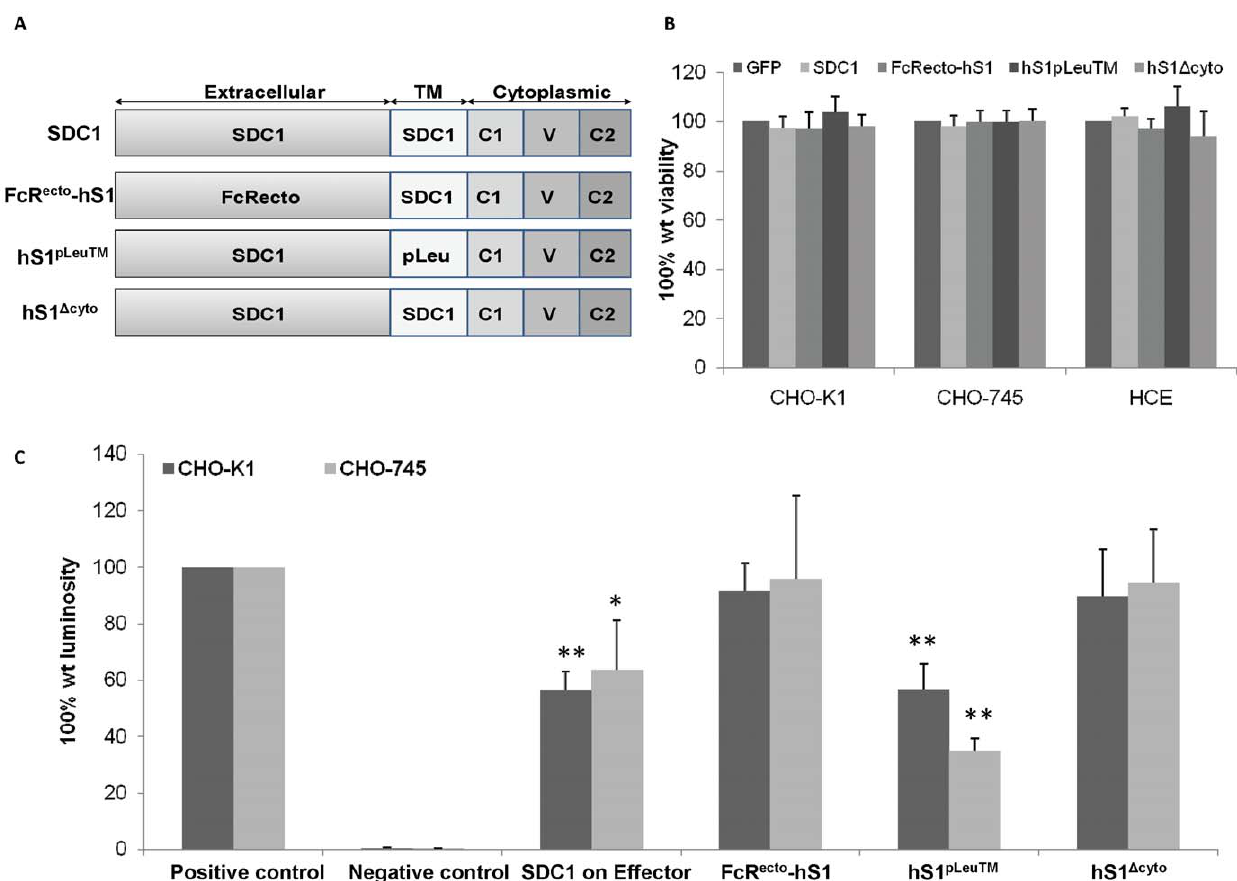
Figure 4. syndecan-1 ectodomain and cytoplasmic domains are important for inhibiting cell fusion when overexpressed on effector cells. (A). Syndecan-1 truncation and mutants used in the study are illustrated including the full-length wild type ( wt ) core protein syndecan-1 (SDC1) that includes an extracellular domain, transmembrane domain (TM), and COOH-terminal cytoplasmic domain. Also illustrated are the construct FcR ecto hS1 that is a chimera comprised of the ectodomain of human IgG Fc c receptor Ia/CD64 fused to the transmembrane and cytoplasmic domains of human syndecan-1, the construct hS1 pLeuTM that has the transmembrane domain replaced with leucine residues, and a truncation mutant hS1 D cyto that lacks the 33 C-terminal amino acids. (B) Cells were grown in 96-well plates, transfected with control GFP plasmid, full-length wt human SDC1 plasmid, the construct FcR ecto hS1, the construct hS1 pLeuTM , or the construct hS1 D cyto for 24 h. Triplicate wells were evaluated for cell viability using MTS assay. Results are expressed as 100% wild type (wt) viability where they represent the percent corrected absorbance after subtracting the background absorbance, relative to control GFP plasmid transfected cells, and are mean 6 1SD of at least 3 independent experiments. (C). Effector cells for CHO-K1 and CHO-745 cells were transfected with either control GFP plasmid, full-length wt syndecan-1, the construct FcR ecto hS1, the construct hS1 pLeuTM , or the construct hS1 D cyto and mixed with the target cells 24 h post-transfection. Fusion was measured 16 h post mixing. Results are presented as mean 6 1 SD of at least 3 independent experiments. As a negative control, target cells were mixed with effector cells lacking HSV-1 gB.